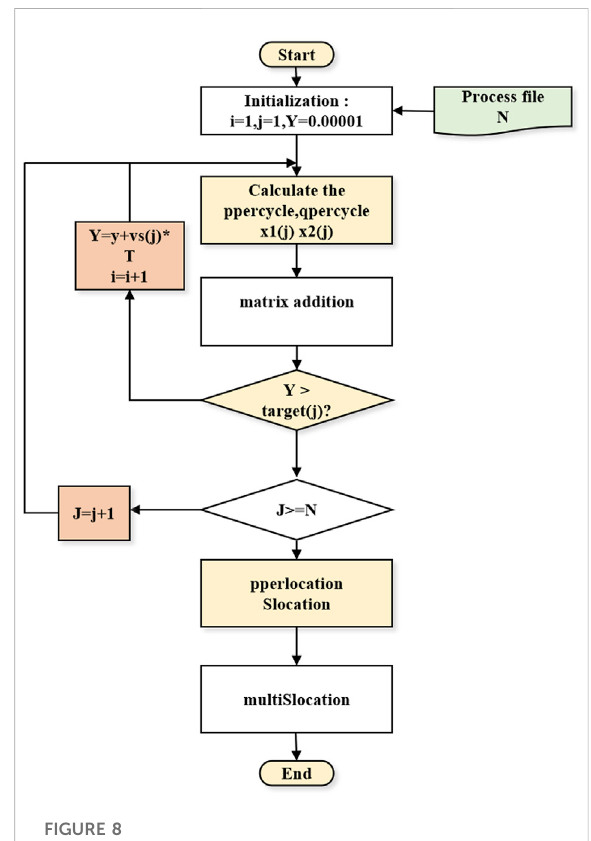
TABLE 1 Simulation process parameters.